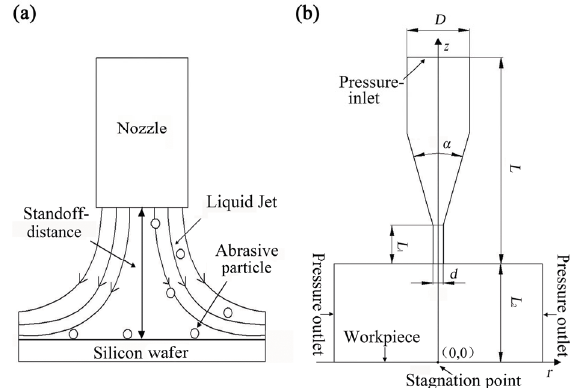
Fig. 1 (a) Schematic drawing of the FJP process. (b) The geometry of the simulation.